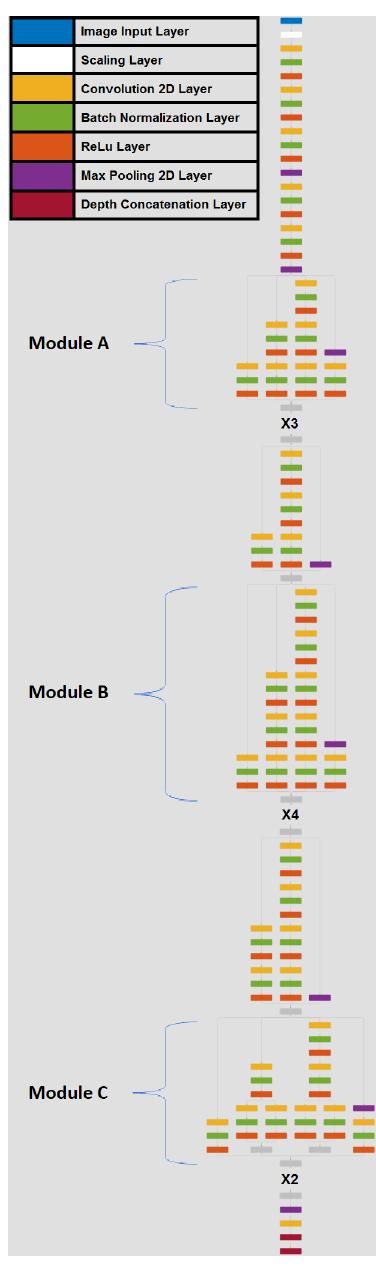
Figure 1. Inception V3 network architecture as implemented in the current